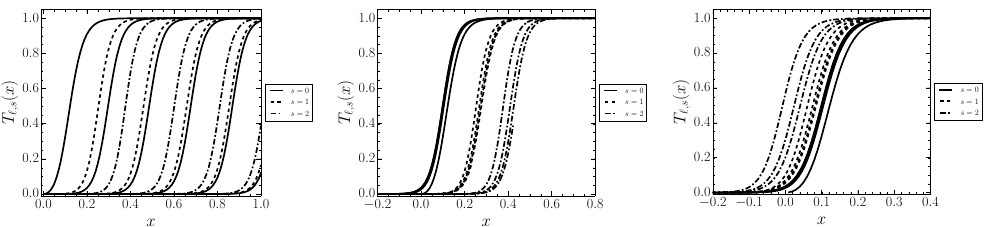
Figure 3. Regge–Wheeler for Schwarzschild: Superimposed greybody factors . Note the very strong similarities and relatively minor differences. The greybody factors almost seem to be translations of one another, and are very similar to suitably shifted hyperbolic tangent functions. The left hand Figure merely superimposes the greybody factors. The middle Figure translates the greybody factors to the s ) / √ 27 before superimposing them. The right hand Figure translates the greybody factors left by ( (cid:96) − to the left by (cid:96) / √ 27 before superimposing